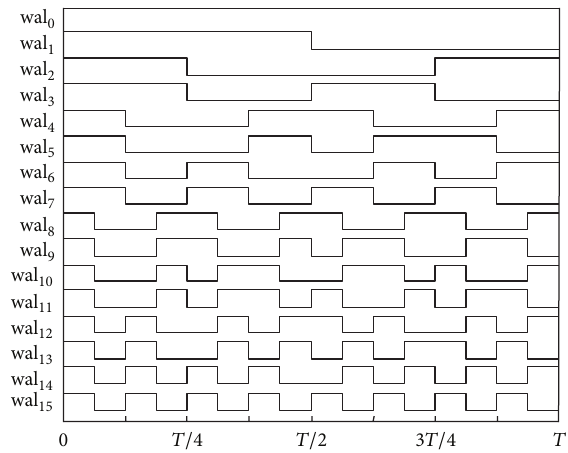
Figure 2: Schematic representation of the Walsh functions wal 𝑇 (𝑛,𝑡) for 0 ≤ 𝑛 ≤ 15